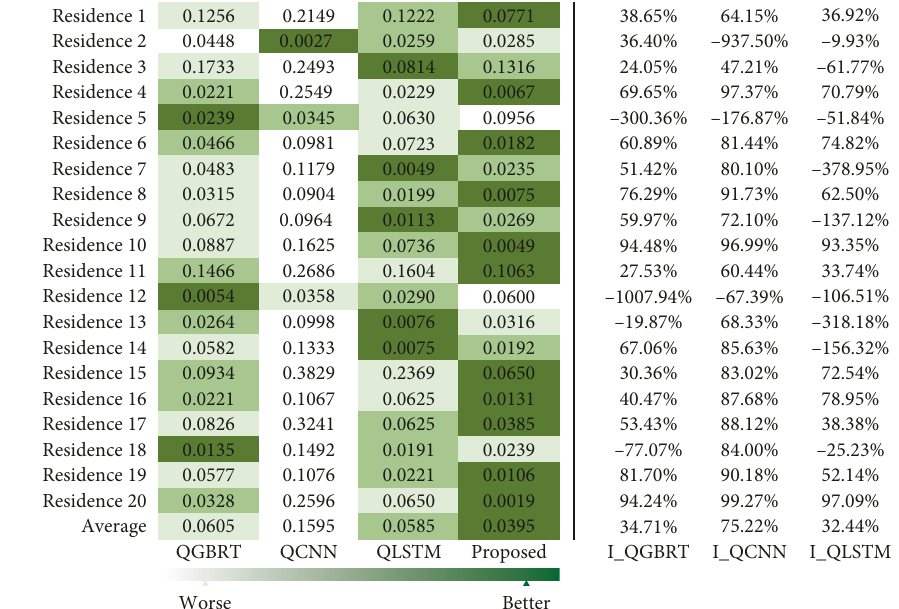
Figure 9: Heat map of 80% interval AACE for four models. QGBRT, QCNN, QLSTM, and our proposed model in X -axis correspond to AACE for different models, while I_QGBRT, I_QCNN, and I_QLSTM represent the AACE improvement ratio of our proposed model over other three models. Y -axis expresses different 20 residences. AACEs of the same residence are listed in the same row, where darker green shades imply a better performance.